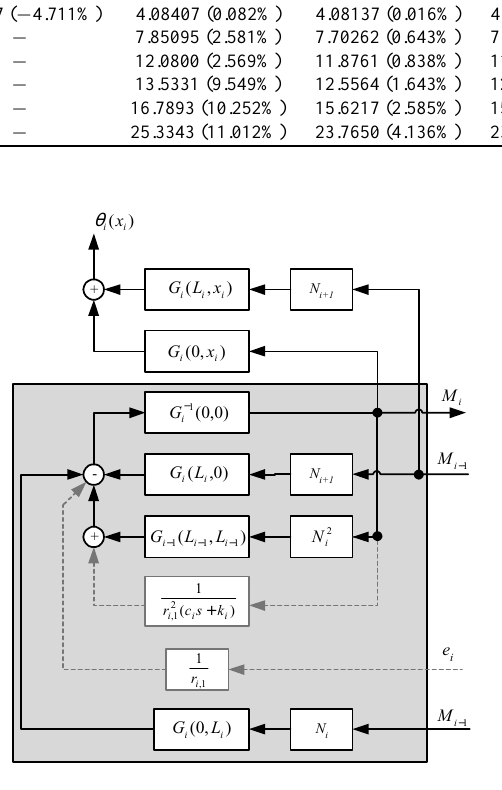
Fig. 9. Generic, single link block